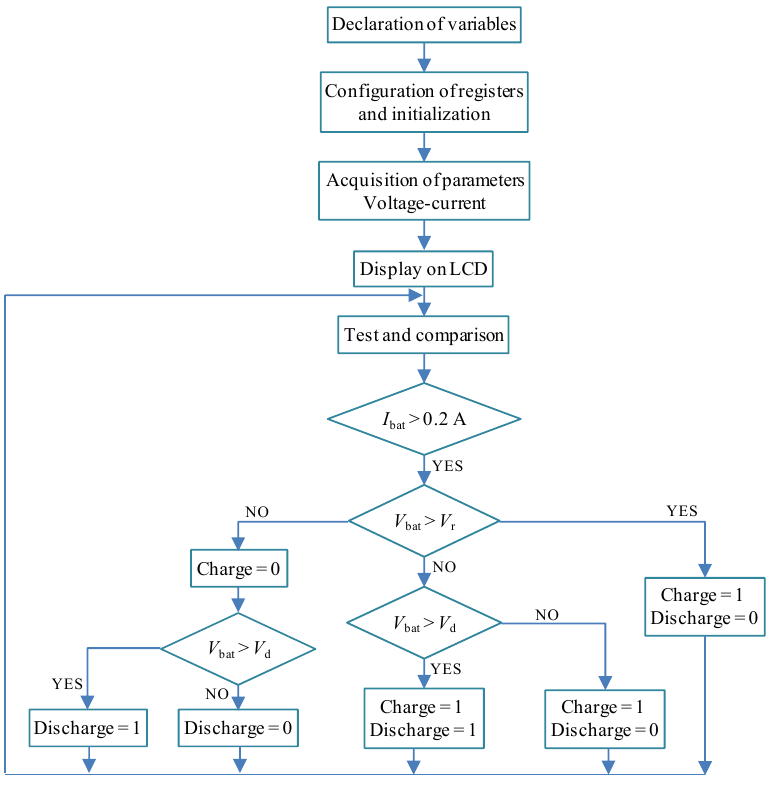
Figure 8. The battery voltage ( V